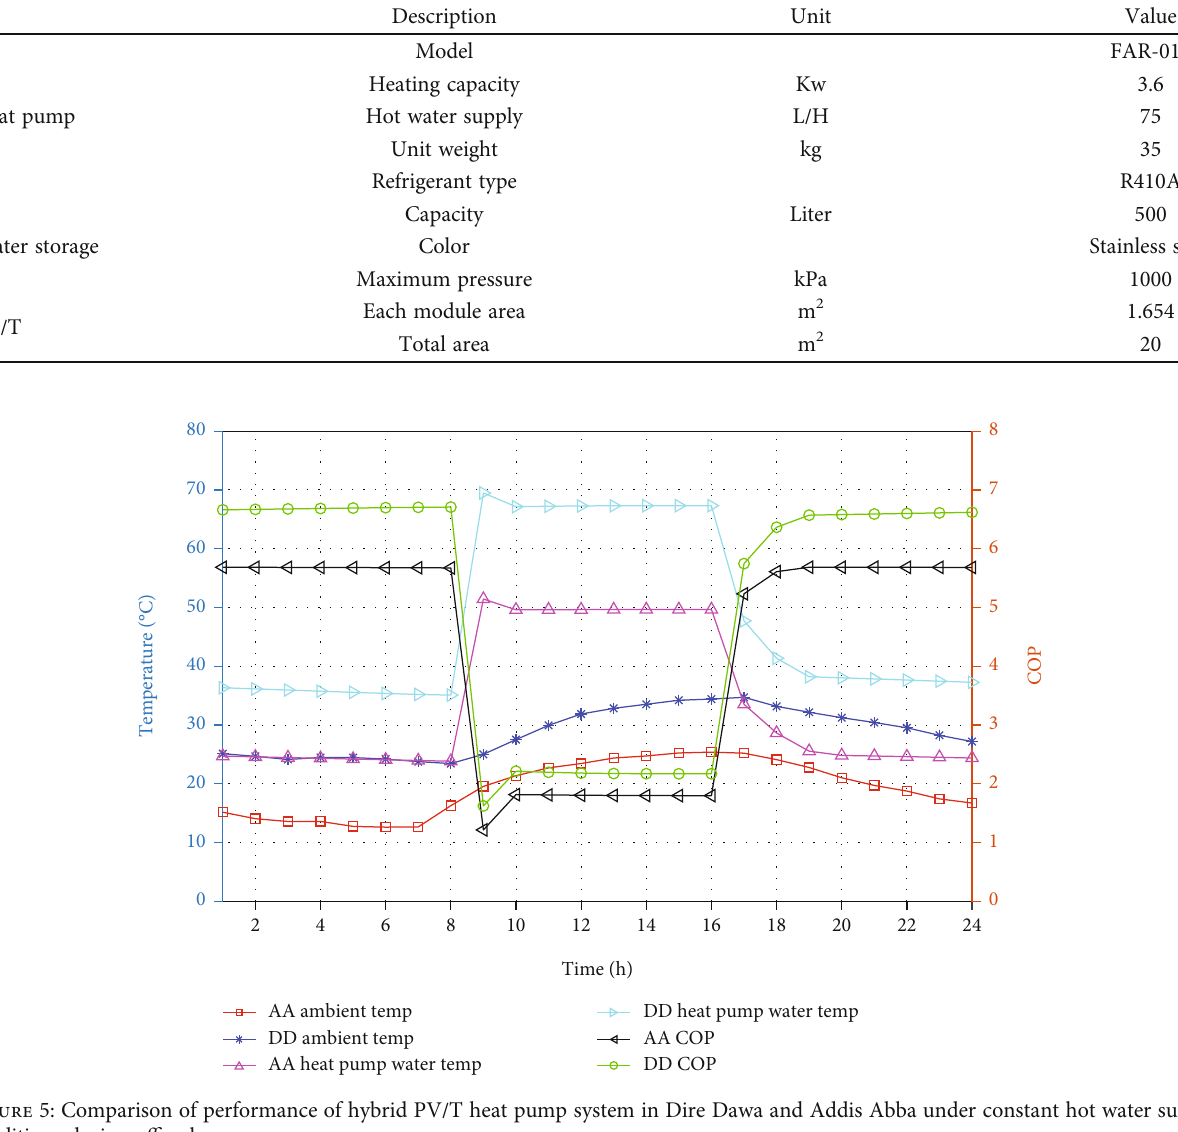
Table 2: Technical data of the hybrid PV/T heat pump system used for